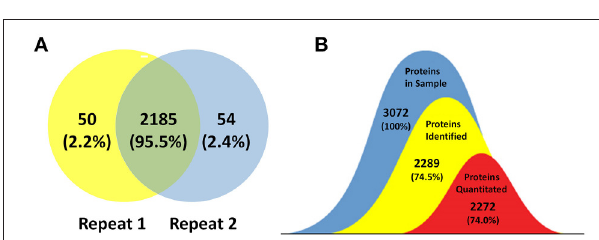
FIGURE 2 | Coverage of the B. abortus proteome by high-resolution mass spectrometry. (A) Venn plot of protein identification overlaps among two independent biological experiments. The number of proteins identified in the B. abortus proteome were 2,289, with 2,235 and 2,239 in the respective experiments. (B) The number of proteins identified in at least two out of nine groups and considered for label-free quantification was 2,272. The coverage of proteins identified and proteins quantitated in this study was 74.5 and 74%,